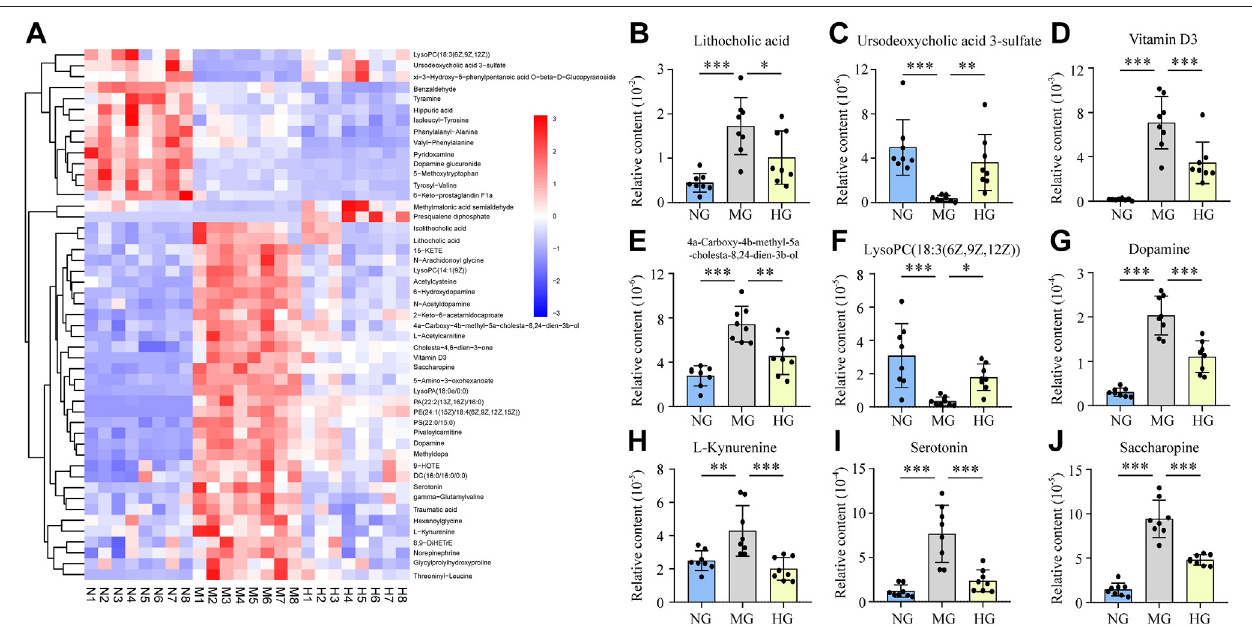
FIGURE 4 | Relative contents of potential biomarkers in NG, MG, and HG, *** p < 0.001, ** p < 0.01, * p < 0.05 (A) heatmap expressed relative contents of potential biomarkers,histograms expressed relative contentsoflithocholic acid (B) , ursodeoxycholicacid3-sulfate (C) ,vitaminD3 (D) ,4a-carboxy-4b-methyl-5a-cholesta-8,24- dien-3b-ol (E) , lysoPC(18:3(6Z,9Z,12Z)) (F) , dopamine (G) , L-kynurenine (H) , serotonin (I) , and saccharopine (J)